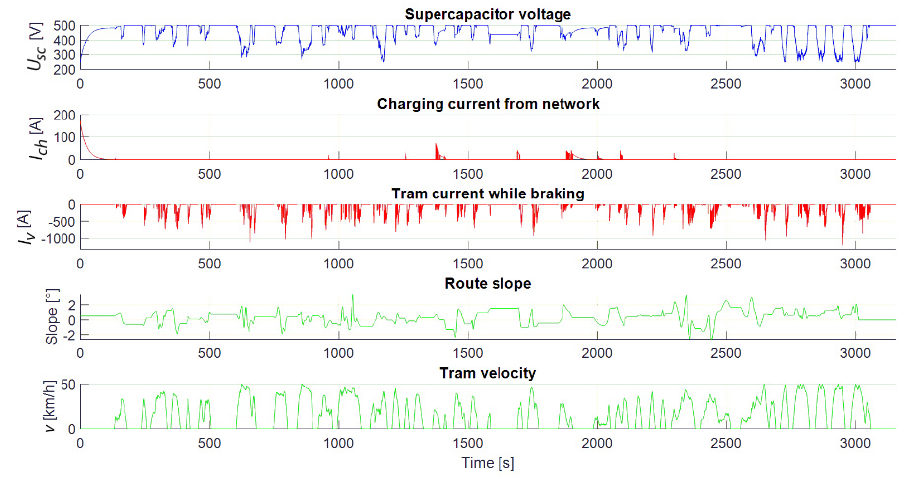
Figure 19. Waveforms during supercapacitor charging while using the minimum gradient algo- rithm.